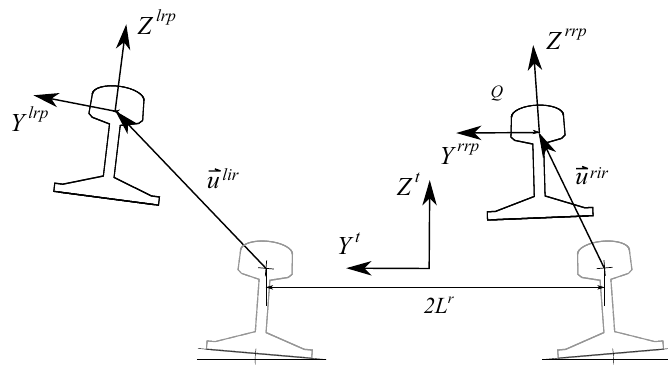
Figure 2. Definition of track irregularities.